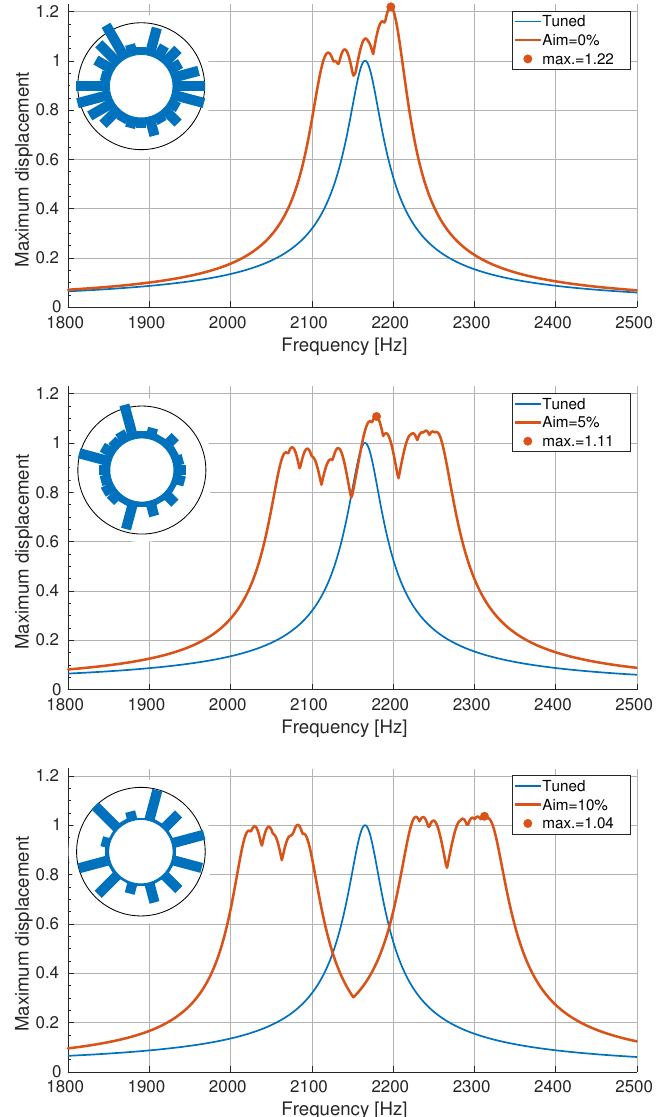
Figure 6. Frequency sweep and (inset) blade displacement at the maximum (black line corresponds to the tuned amplitude), for Aim = 0% ( top ), Aim = 5% ( middle ), and Aim = 10% ( bottom ). Rotor A, alternate pattern, ξ = 10 − 2 .